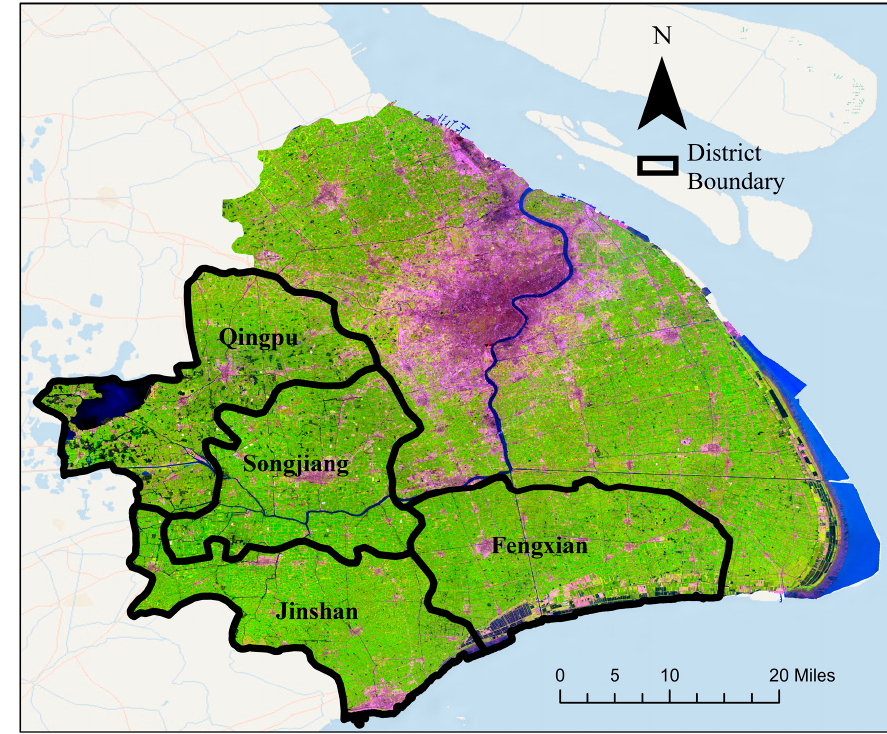
Figure 1. Our study sites are located in four districts of Shanghai, including Jinshan, Fengxian, Qingpu, and Songjiang. The background is an original raw image of Landsat TM 5 obtained on day of year (DOY) 224 in year 1995, with a band combination 5-4-3. Green colors in the map indicate forest land cover and croplands. Purple colors in the map represent urban and build-up